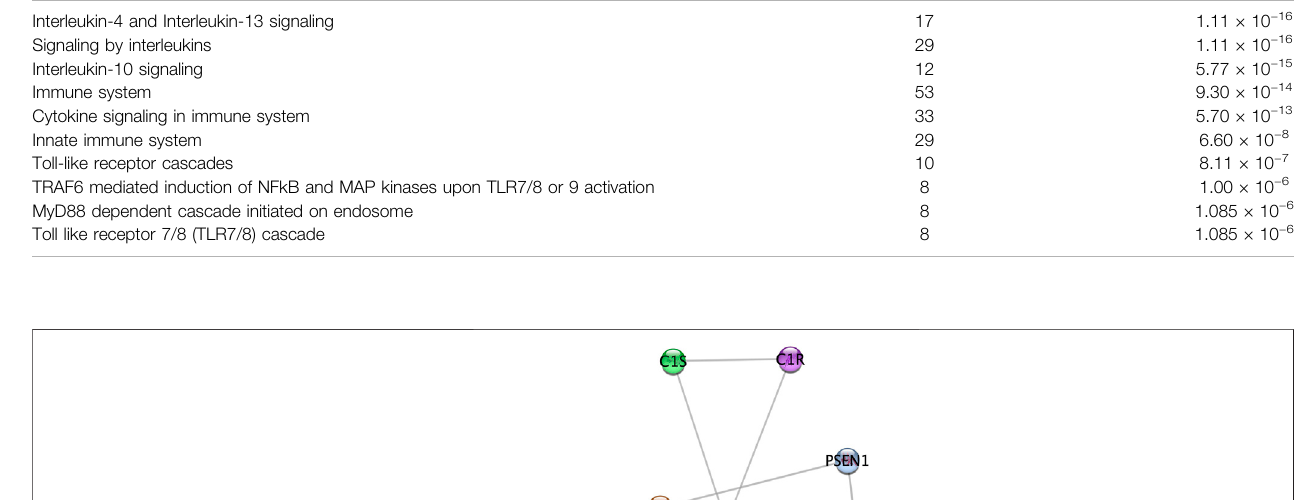
TABLE 1 | Function enrichment results of proteins associated to neuroin fl ammation in Alzheimer ’ s disease using the Reactome Pathway database. Count: enriched gene number in the category. Term